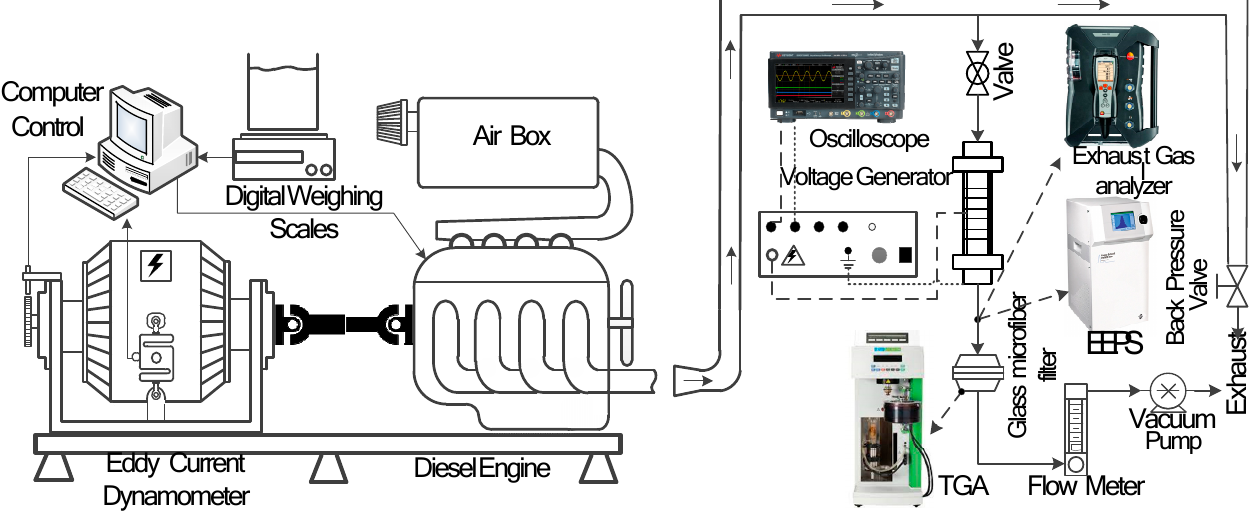
Figure 1. Schematic diagram of the experimental design. Table 1. Engine specifications.